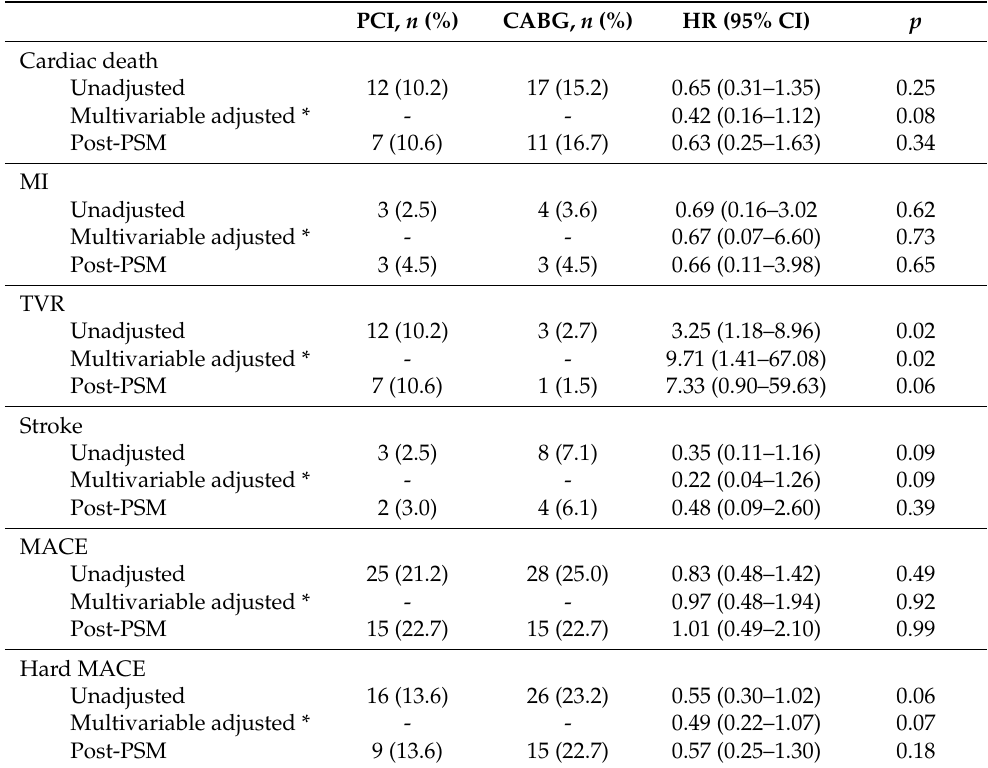
Figure 3. Kaplan–Meier survival analyses of clinical endpoints. Unadjusted Kaplan–Meier plots of ( A ) cardiac death, ( B ) myocardial infarction (MI), ( C ) stroke, and ( D ) target vessel revascularization (TVR) is shown. CABG, coronary artery bypass graft; PCI, percutaneous coronary intervention; HR, hazard ratio. Table 3. Unadjusted, multivariate adjusted, and post-PSM analysis of